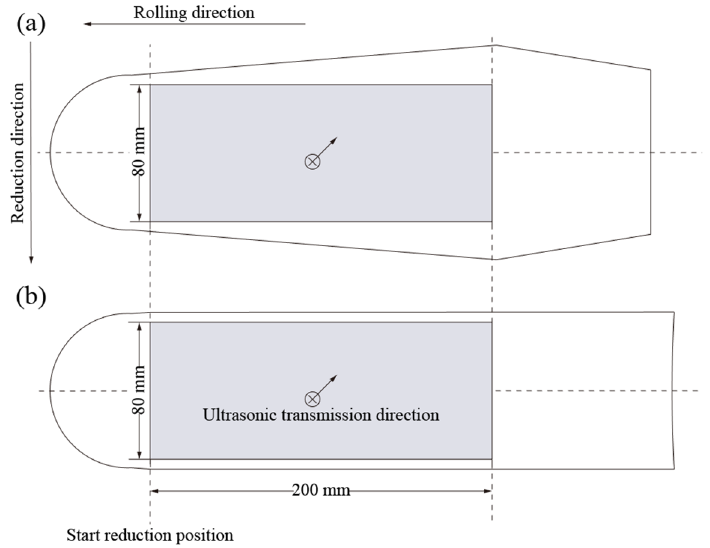
Figure 4. Schematic of the ultrasonic scanning area: ( a ) specimen without reduction; ( b ) specimen with reduction.